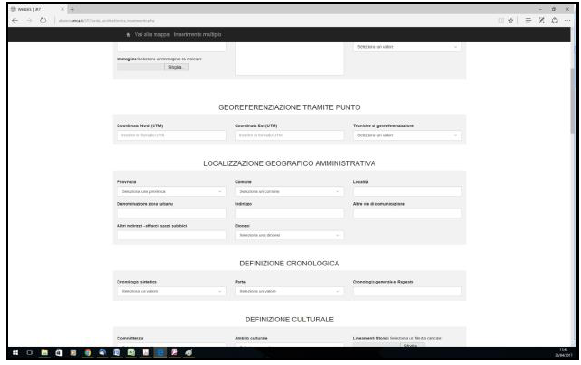
Figure 5. Window fixture input form